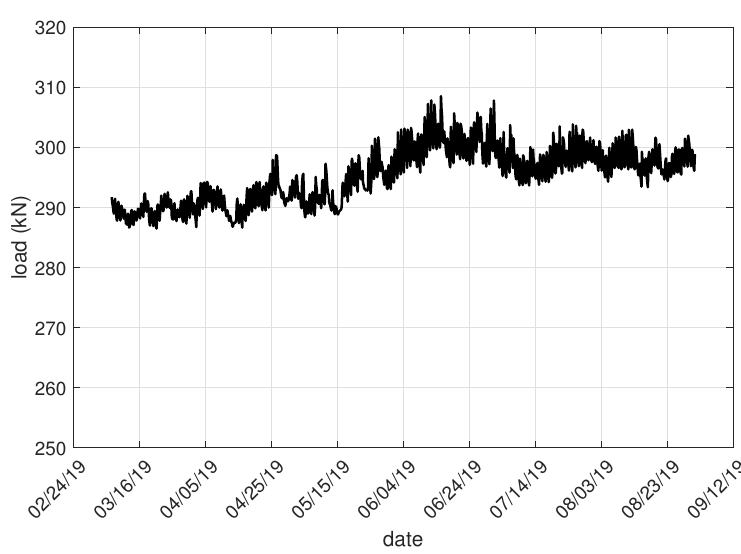
Figure 21. Load at the bottom of the gabion